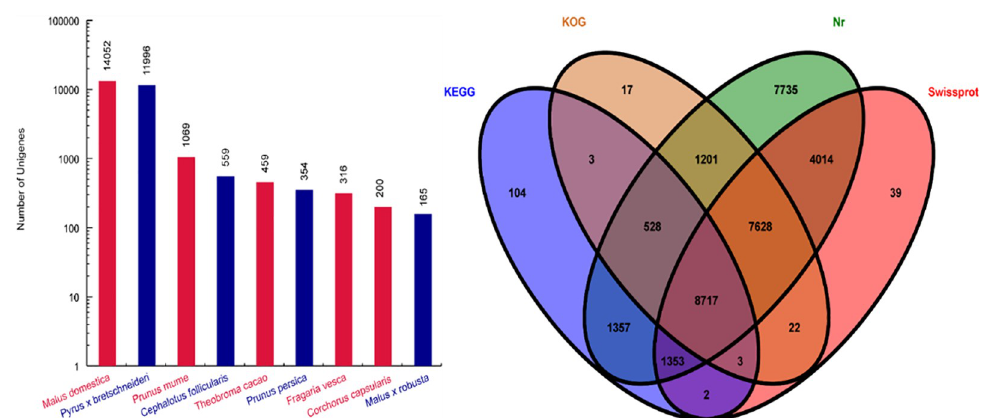
Fig 2. Homology characteristics of E. japonica unigenes. (A) Species distribution of Nr annotation; (B) Venn diagram of Nr, Swiss-Prot, KOG, and KEGG annotation.